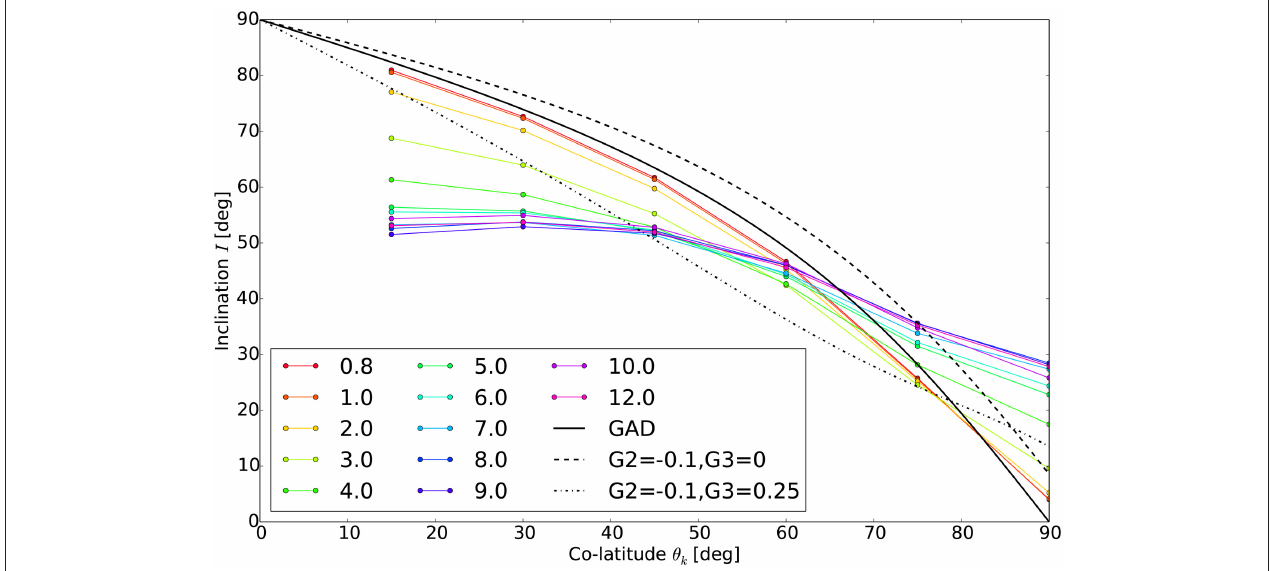
FIGURE 8 | Known site co-latitude θ k vs. observed inclination I from Figure 7A . Colors correspond to basal heat flux in legend. Also shown is GAD (solid black), GAD plus G 2 = − 0.1 (dashed black), and GAD plus G 2 = − 0.1 and G 3 = + 0.25 (dash-dot black). The relative amplitudes of the quadrupole G 2 = g 2,0 / g 1,0 and G 3 = g 3,0 / g 1,0 shown are from Kent and Smethurst